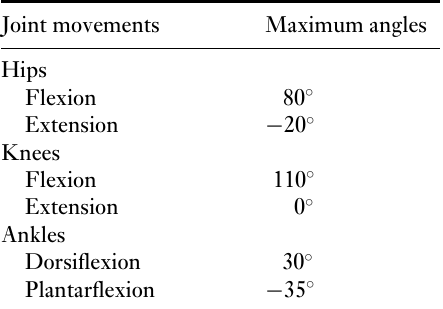
Figure 17 Hip flexion/extension torque.